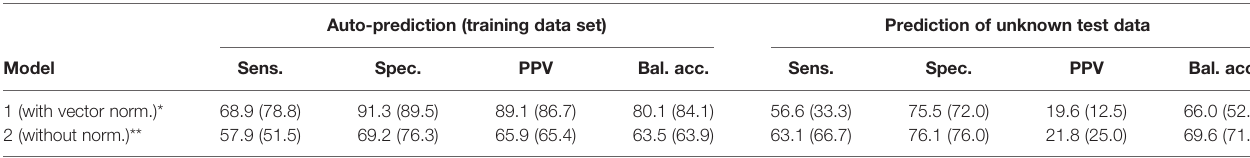
TABLE 3 | Summary on model performance of the automatically optimized models during auto-prediction (training data set, left) and during prediction of unknown test data set (right). Auto-prediction (training data